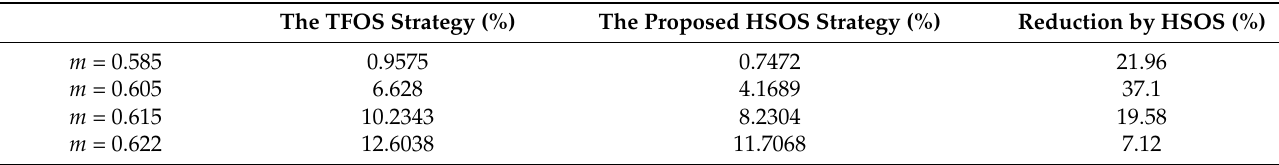
Table 3. Voltage THD Z1Z2 of the two strategies in simulation.